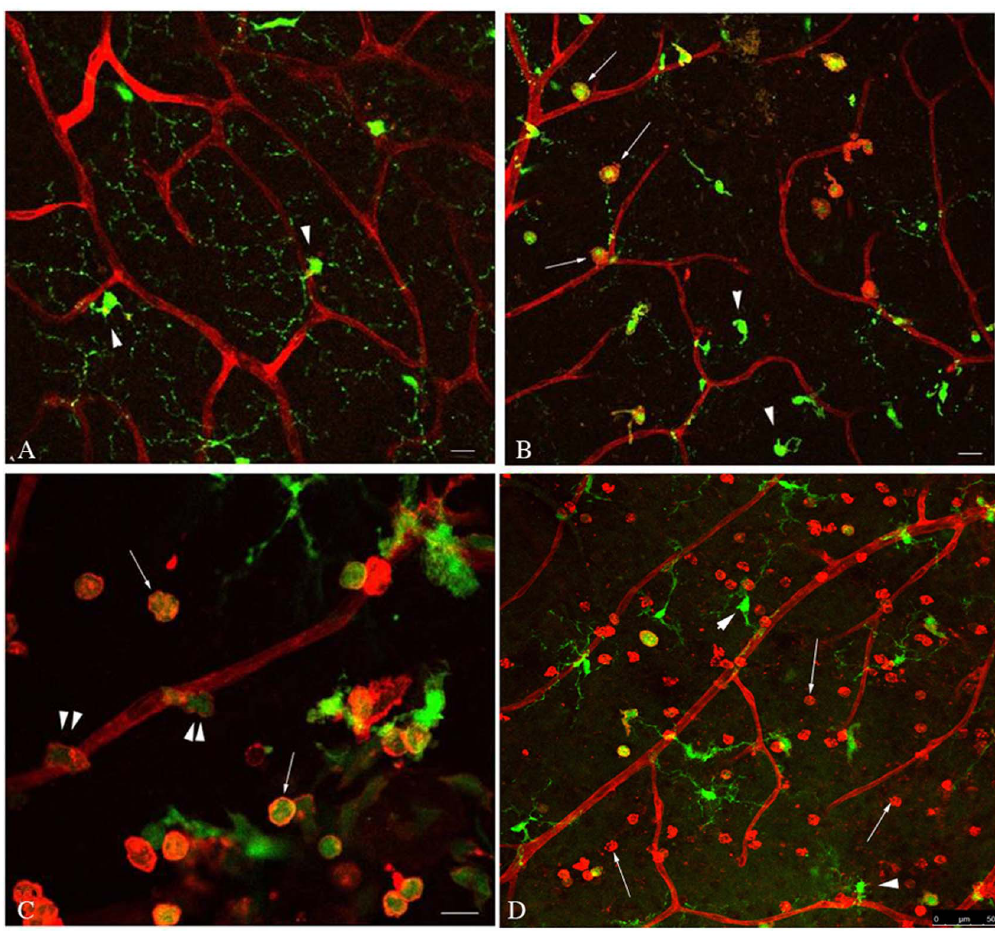
Figure 3. Diabetes or intraocular injection of CCL2 increases monocyte/macrophage infiltration and activates retinal microglia. Representative confocal images of retinal whole mounts from Cx3cr1-GFP mice. Retinas were counterstained with TRITC-labeled GS-IB4 isolectin (red) for vessel and activated monocyte/macrophage identification. ( A ) Normal non-diabetic mice showed isolectin labeled vessels and GFP + retinal microglia (green) (arrowheads) uniformly distributed with ramified processes. ( B ) Retina from a 4 week diabetic animal demonstrates several GFP + / isolectin + round cells closely associated with the external surface of the vessels (arrows). In addition, GFP + microglial cells exhibit altered morphology typical of an activated state (arrowheads). ( C ) High magnification image of the retina from a diabetic animal demonstrates co-localization of GFP and isolectin to several of the extravascular monocytes/macrophages within the retinal tissue (arrows). As the isolectin stains activated monocytes in addition to blood vessels, some of the round cells (monocytes/macrophages) also stain red. Further, several GFP + monocytes/macrophages presumably in the process of diapedesis are seen (double arrowheads). ( D ) Mouse retina 16 hours after intraocular injection of purified CCL2 (5 ng). Numerous GFP + /isolectin + activated monocytes/macrophages (arrows) and microglia (arrowheads) are present within the extravascular space, with an altered morphology.